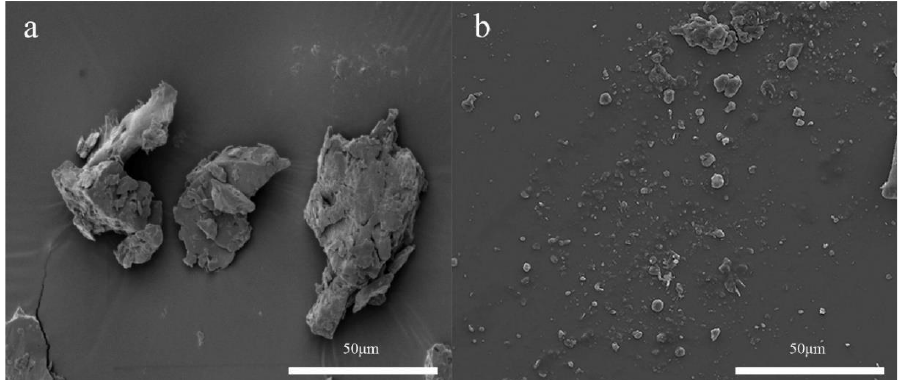
Figure 3. The morphology of food waste samples under SEM: ( a ) control (untreated) food waste sample, ( b ) sonicated food waste sample using a 35 mm horn (at 0.34 W/mL power). The SEM pictures were obtained at a magnification of 2000 [70]. Note: The scale bar is 50 μ m .